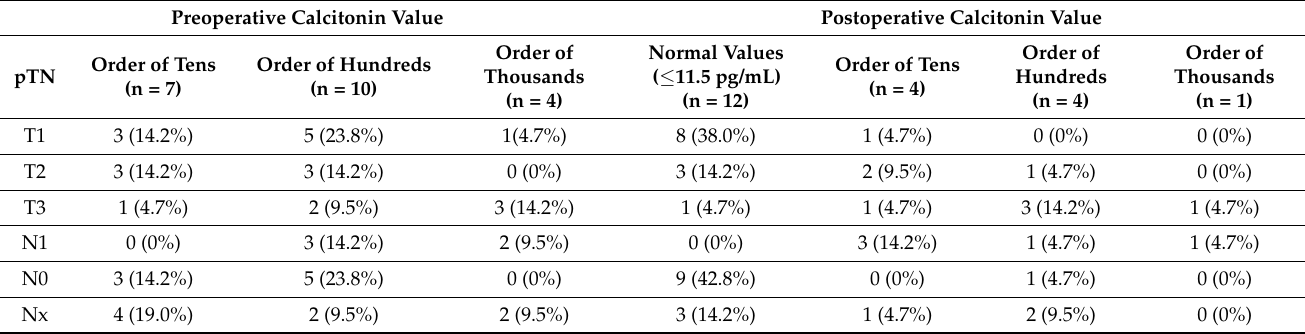
Table 2. Pre- and postoperative calcitonin value corresponding to pTN